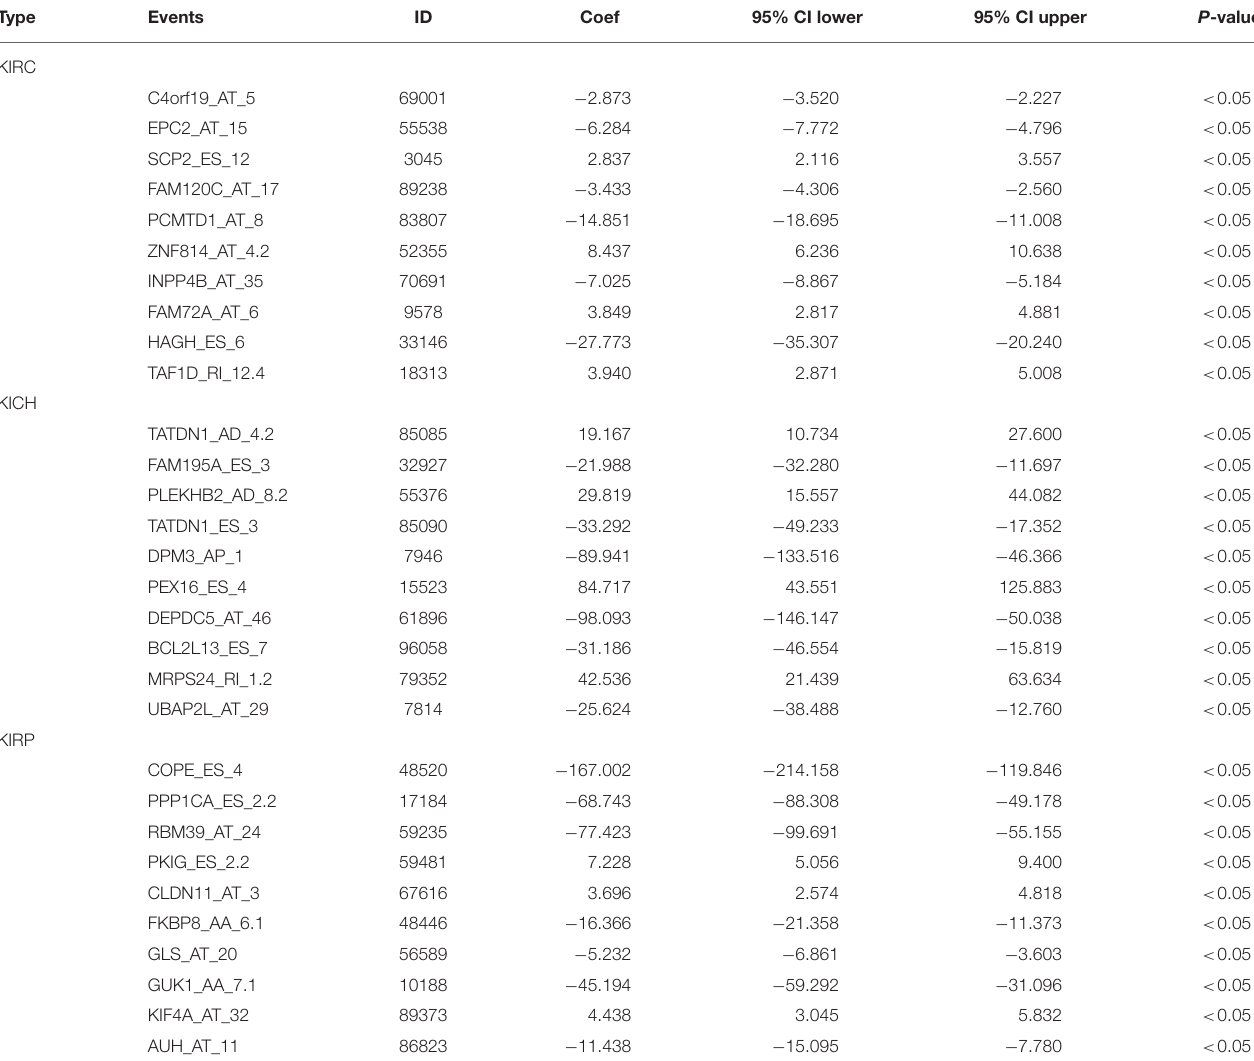
TABLE 1 | The information of top10 survival related events.